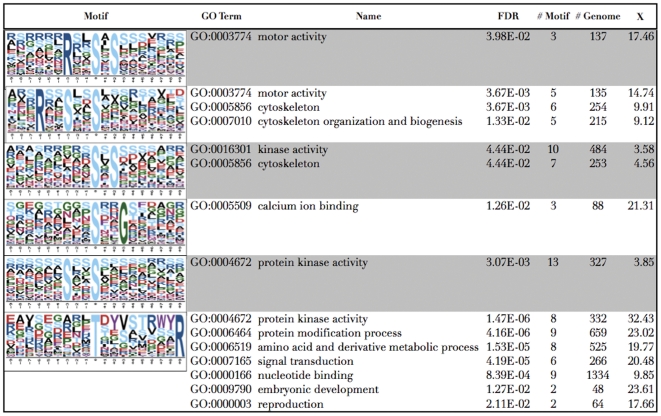
Motifs found to have GO terms overrepresented.